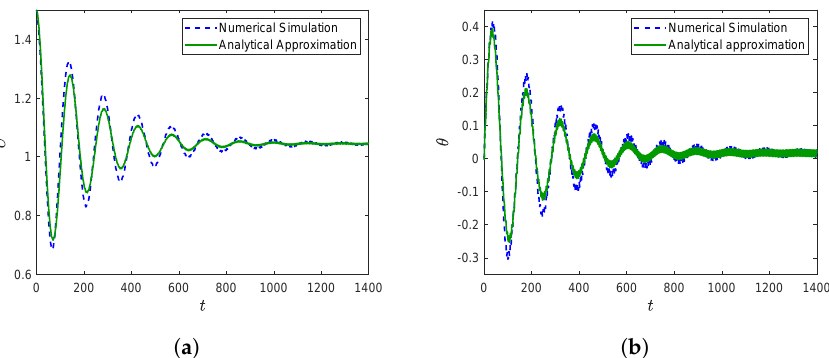
Figure 7. Comparison between theoretical and numerical transient phase at 5Hz. ( a ) Airspeed evolu- tion; ( b ) pitch angle evolution.